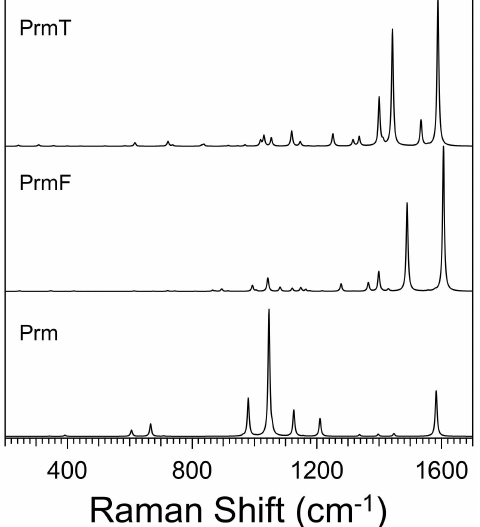
Figure 8. Simulated Raman spectra of pyrimidine (Prm) compared to that of PrmF and